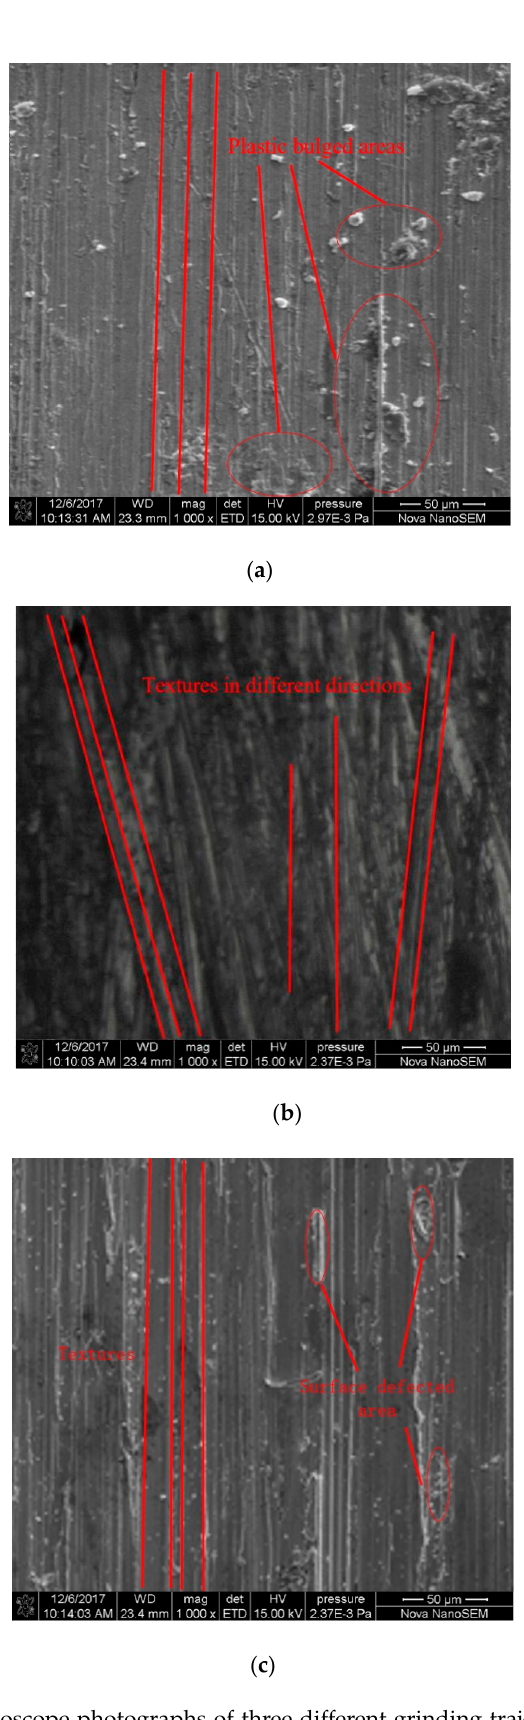
Figure 7. Electron microscope photographs of three different grinding trajectories. ( a ): Line type; ( b ): Circular type; ( c ): Z-type.